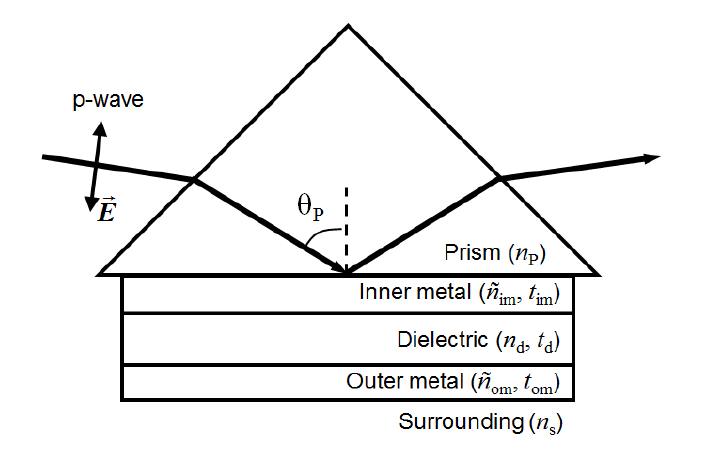
Figure 1. Schematic geometry of the present bimetallic WCSPR sensor used for theoretical calculation.